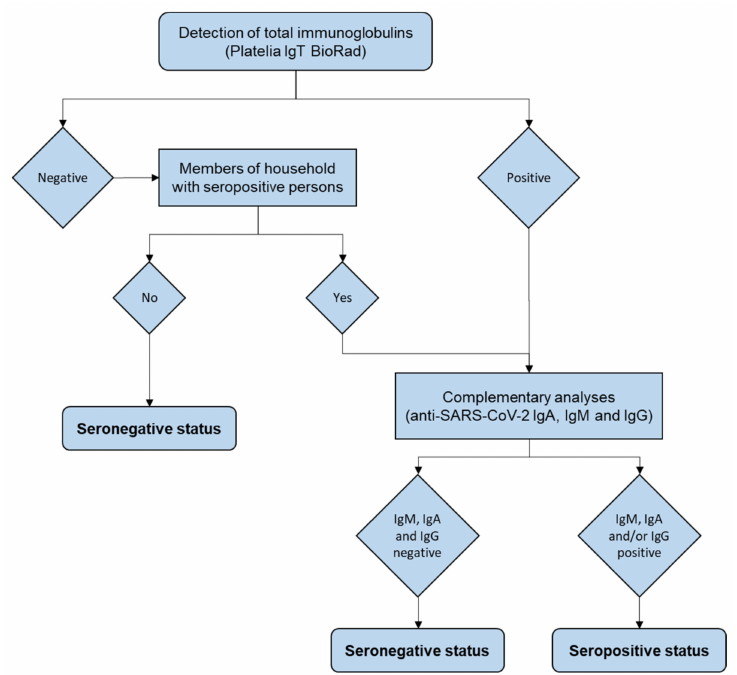
Figure 1. Flow of serology testing in the